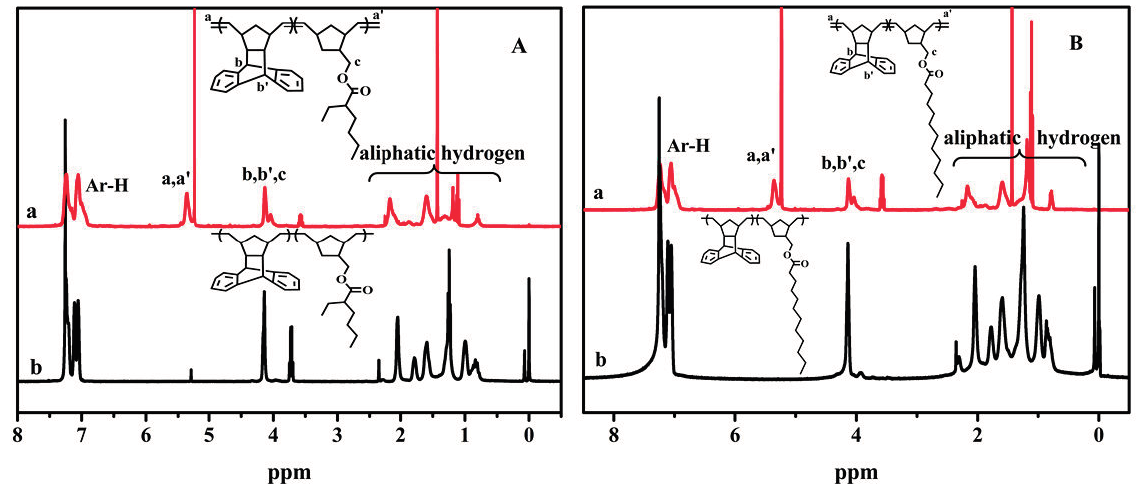
Figure A1. The 1 H NMR spectra for the copolymers. ( A ), (a) poly(HBM-co-NME) (95:5) in CD 2 Cl 2 , (b) corresponding hydrogenated copolymer in CDCl 3 ; ( B ), poly(HBM- co -NMD) (85:15) in CD 2 Cl 2 , and (b) corresponding hydrogenated copolymer in CDCl 3 .